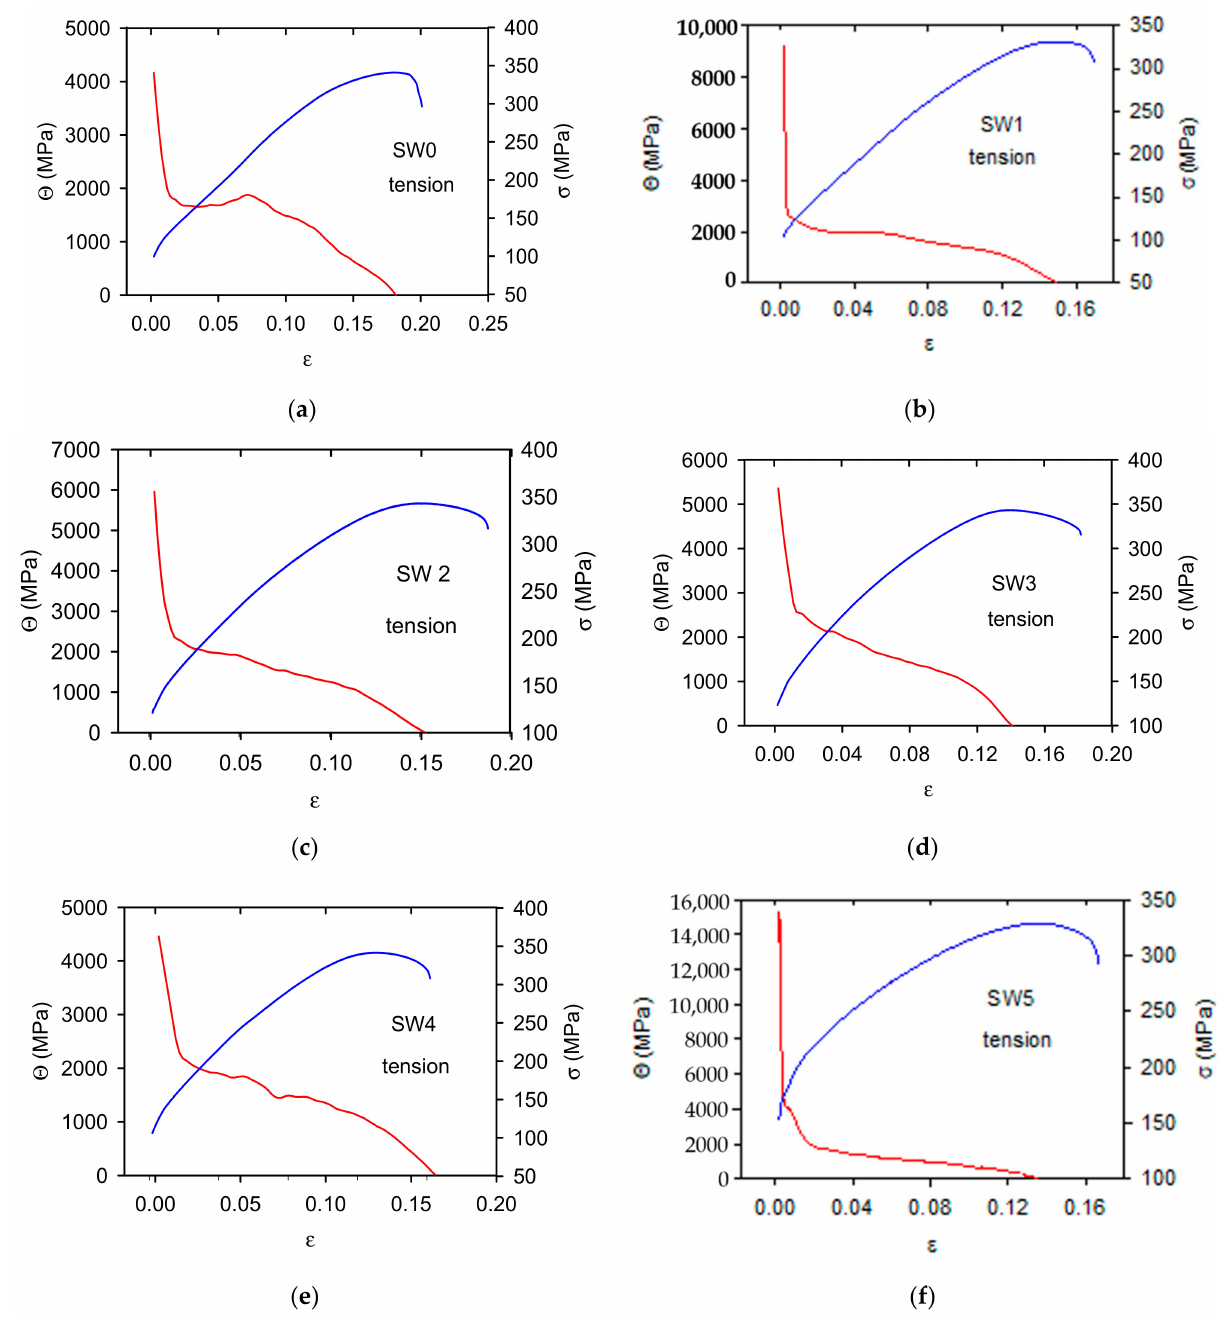
Figure 5. The work hardening coefficients calculated for curves obtained in tension: ( a ) SW0, ( b ) SW1, ( c ) SW2, ( d ) SW3, ( e ) SW4 and ( f ) SW5. σ - ε curves are drawn in the blue colour and Θ - ε curves in